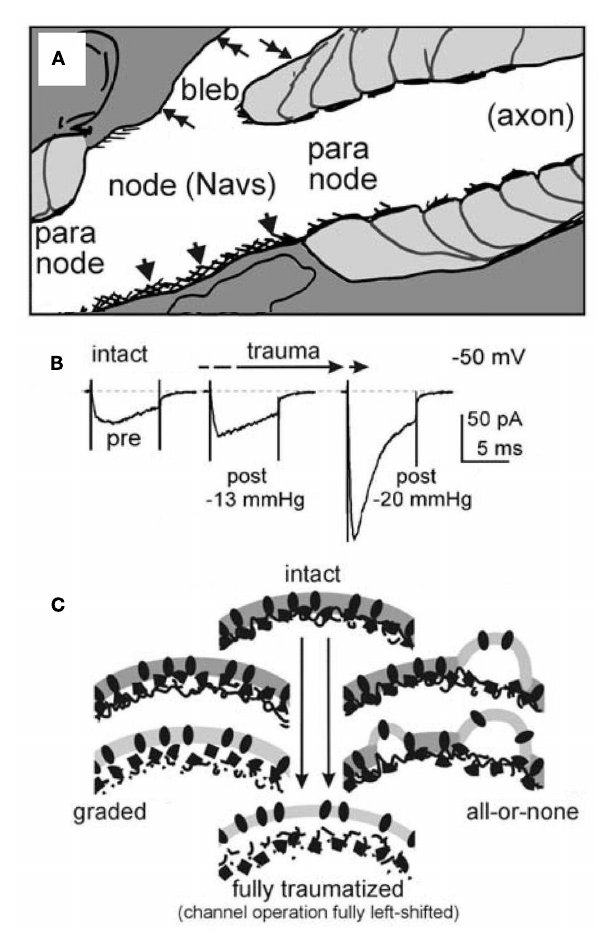
FIGURE 2 | (A) From a stretch-traumatized optic nerve, the nodal and paranodal regions of a node of Ranvier (cartooned by tracing an electron micrograph, Figure 2A of Maxwell, 1996) showing intact (arrowheads) and severely blebbed yet unruptured (double-headed arrows) nodal (hence Nav-rich) axolemma. (B) I Na ( t ) from recombinant α Nav1.6/ β 1 in a cell-attached oocyte patch, before (intact) then again after bouts of pipette aspiration (experimental conditions as inWang et al., 2009).The changing I Na ( t ) (at − 50mV) is consistent with increasingly strong coupled-left shift, the mechanism outlined in Figure 3 . (C) In sick excitable cells, Nav channels that become “leaky,” we assume, experience nano-structural environmental changes; here we depict a Nav-rich membrane going from intact (top) to blebbed (bottom). If I Na changes such as seen in B are due to increasing bilayer entropy, then graded structural changes of each channel’s nano-environments (left) would be expected. If, instead, as suggested by some (Shcherbatko et al., 1999; but see Morris et al., 2006), pipette aspiration induced-blebbing alters Nav kinetics by disrupting discrete channel/cytoskeleton interactions, then each Nav channel will see an all-or-none structural change, such as depicted at right.